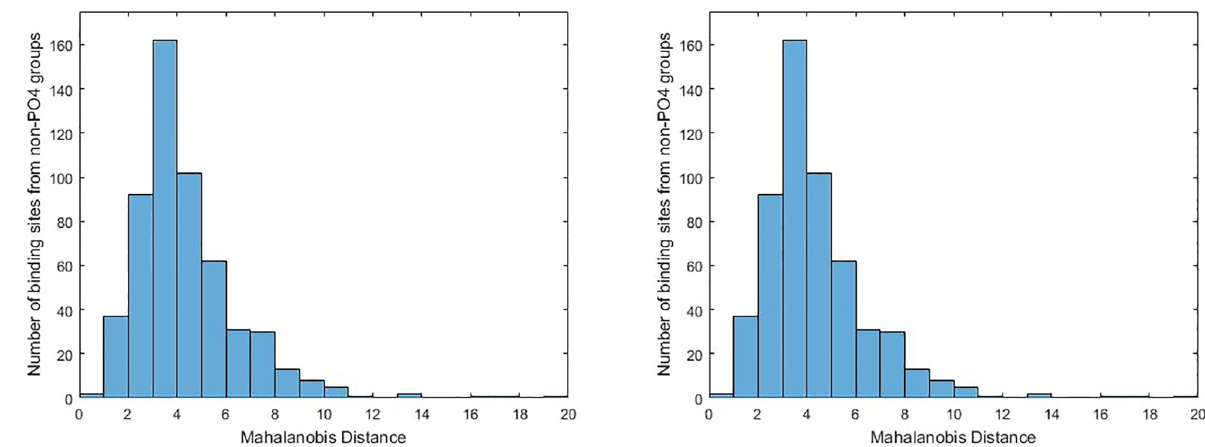
Fig 2. Comparing the distributions of the Mahalanobis distances between binding sites and the mean of each groups. (Left) Mahalanobis distance from each binding site in the PO4 group to the mean of the PO4 group. (Right) Mahalanobis distance from each binding site in the non-PO4 groups to the mean of the PO4